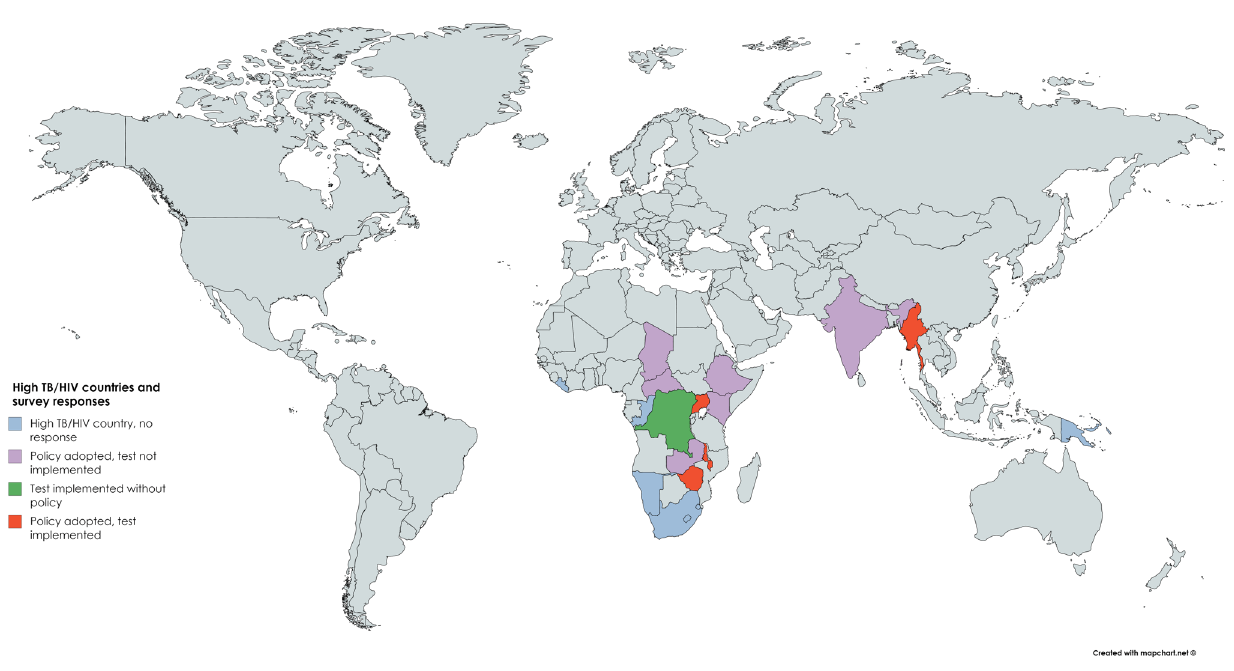
Figure 1. High TB/HIV burden countries contacted for survey. Status of Alere-LAM policy adoption and test implementation are as indicated by colour. Blue indicates countries that were contacted but did not respond to the survey. Purple indicated countries with an Alere-LAM policy but that have not implemented the test. Green indicates that Alere-LAM testing has been implemented without a policy. Red indicates that the country has an Alere-LAM policy and testing has been implemented.